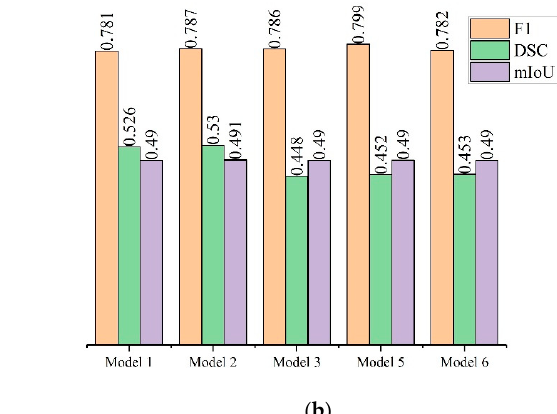
Table 2. Summary table of the test metrics DSC and IoU for models of different architectures.